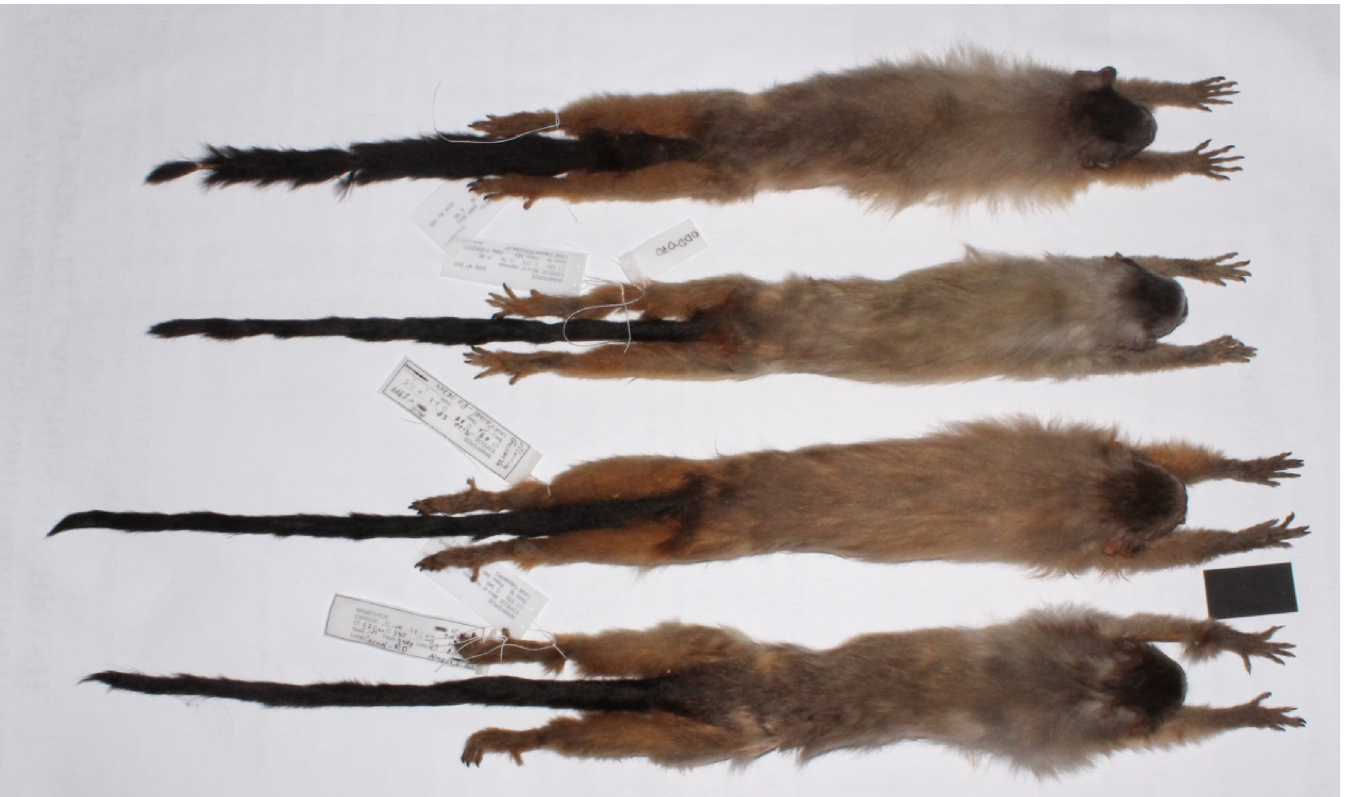
Fig 2. Analyzed skins. Road-kill derived specimens deposited in the Mastozoologia collection, CELBE Pantanal, and analysed for the current study (Photo: O. Silva- Diogo).